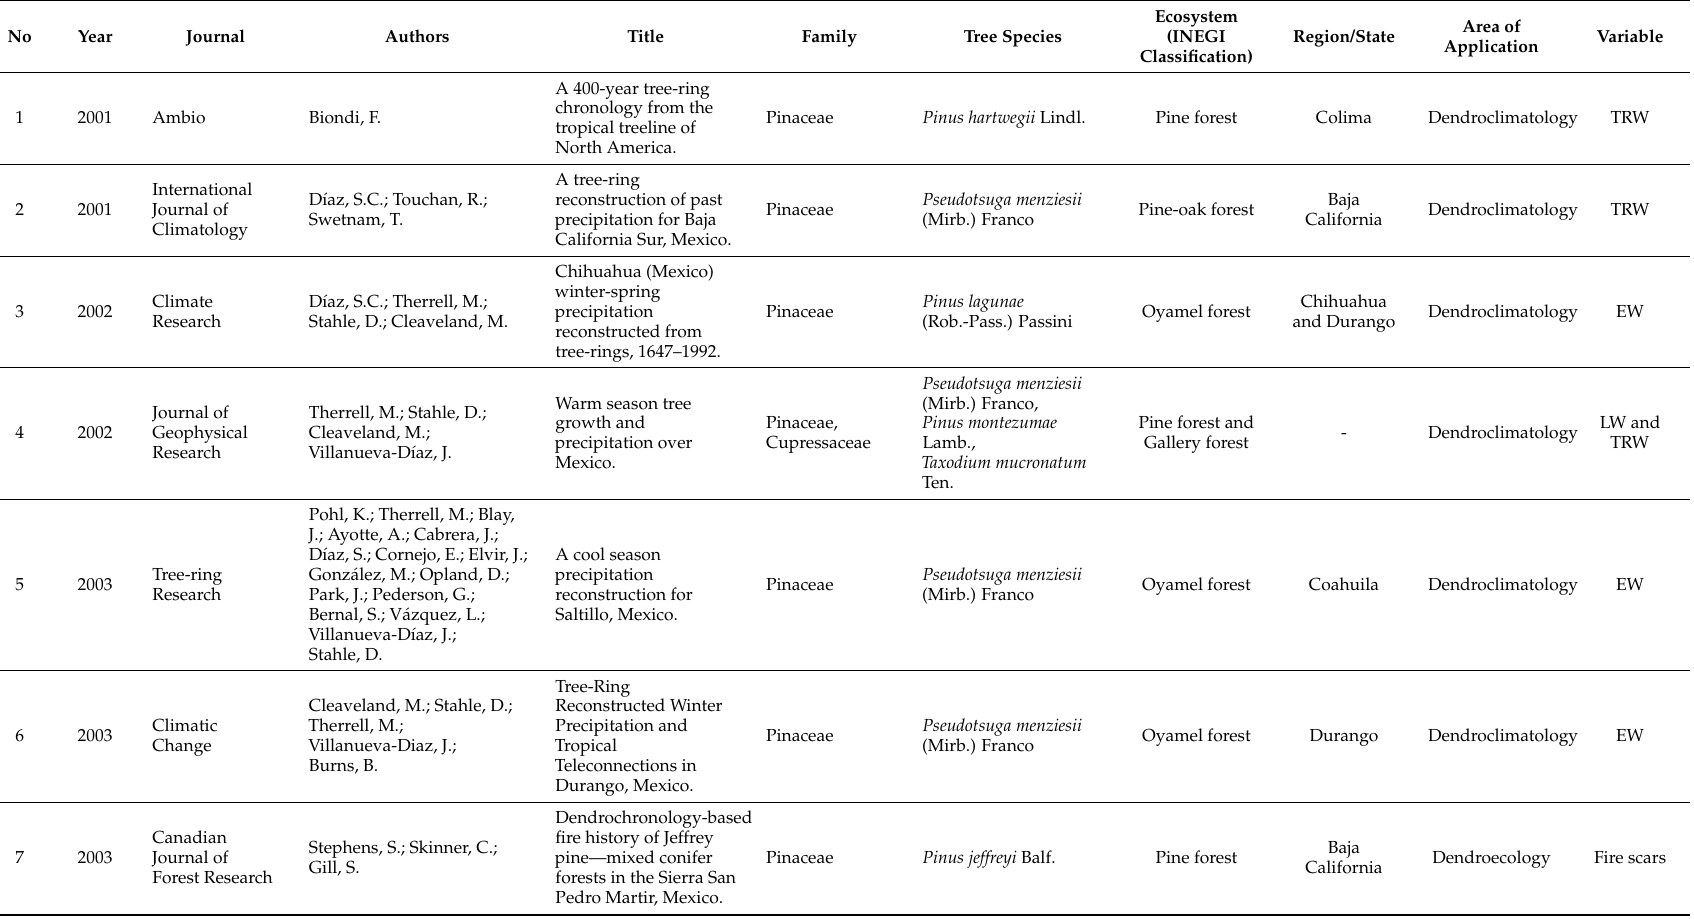
Table A1. List of articles consulted on dendrochronology by species or Mexican forests published in indexed scientific